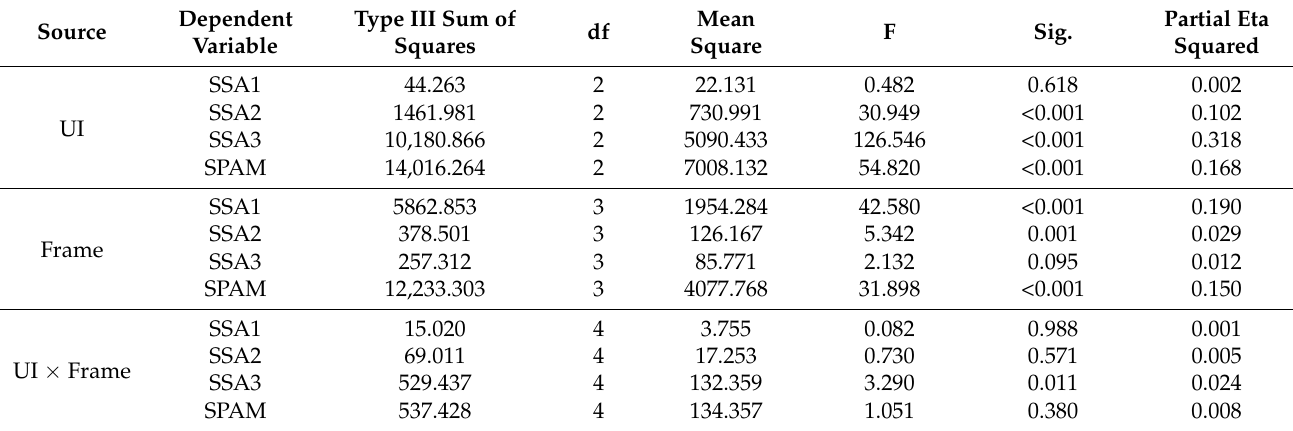
Table 4. Multi-way-ANOVA-analysis results of each stage and the total score of